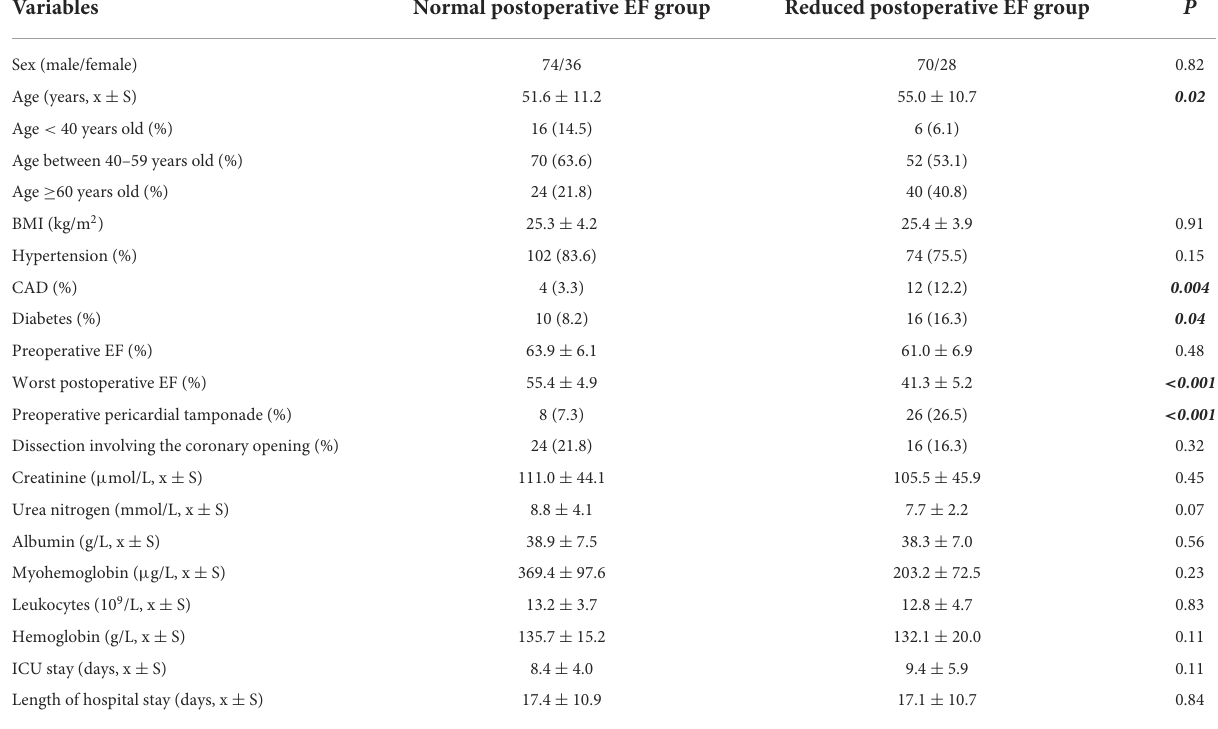
TABLE 1 Comparison of the baseline characteristics between the normal postoperative EF group and the reduced postoperative EF group. Variables Normal postoperative EF